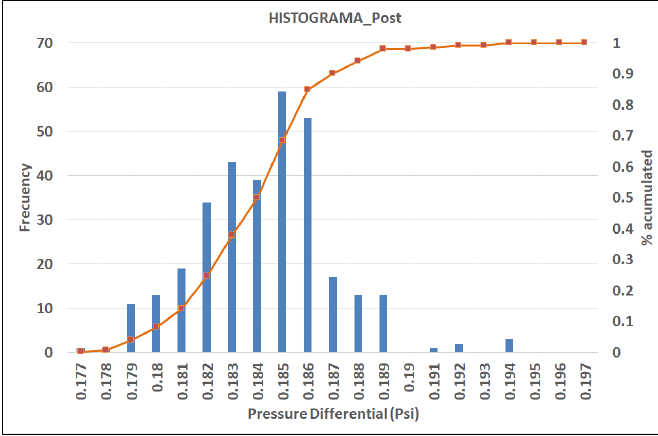
Figure 10: Histogram of the pressure differentials after the modifications made (Phase 2).